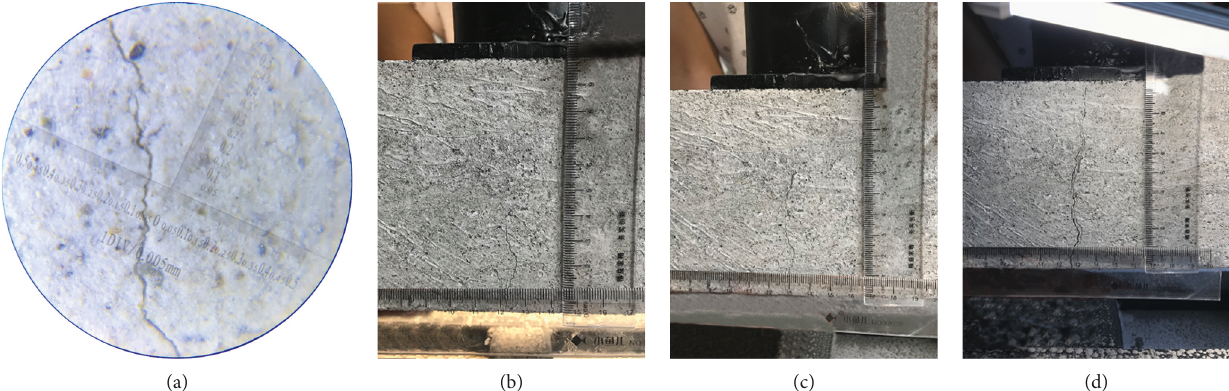
Figure 10: Dynamic bending impact crack diagrams of RC40SF10 beams. (a) Appearance of microcracks in the beams. (b–d) Development of microcracks on the side surface of